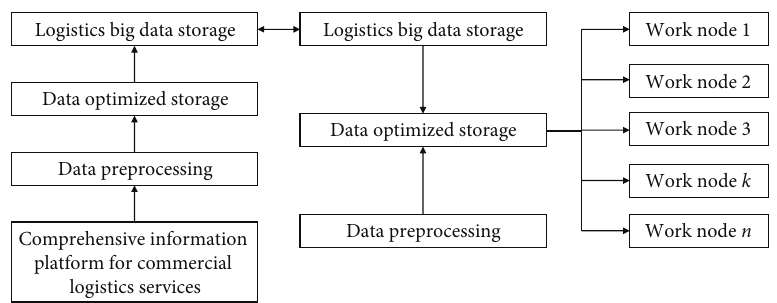
Figure 12: Logistics big data real-time processing